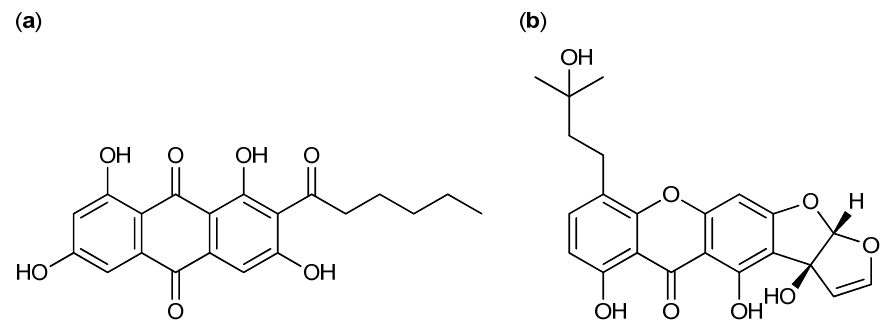
Figure 6. ( a ) Norsolorinic acid and ( b ) Austocystin